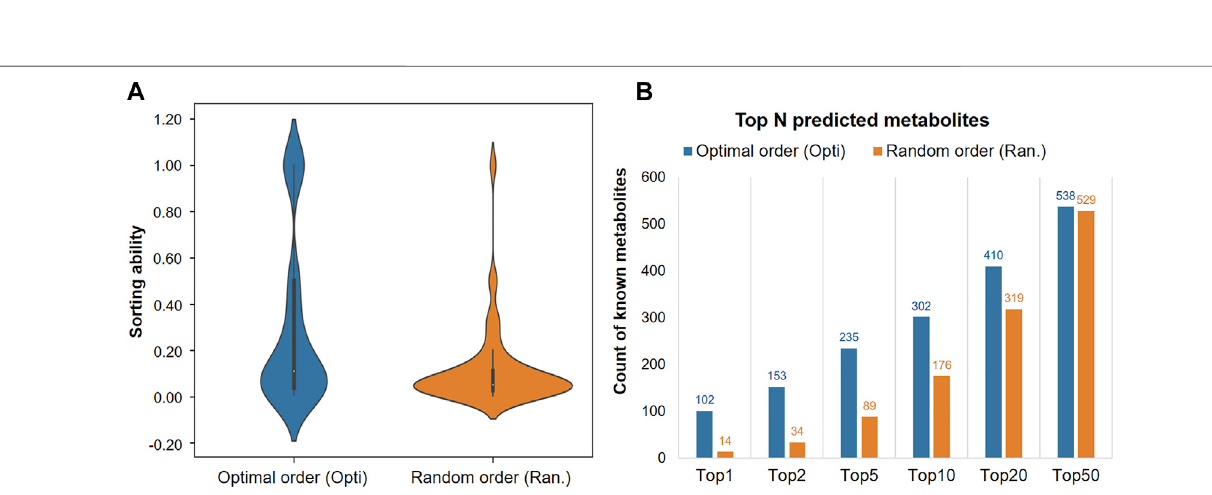
Frontiers in Chemistry |